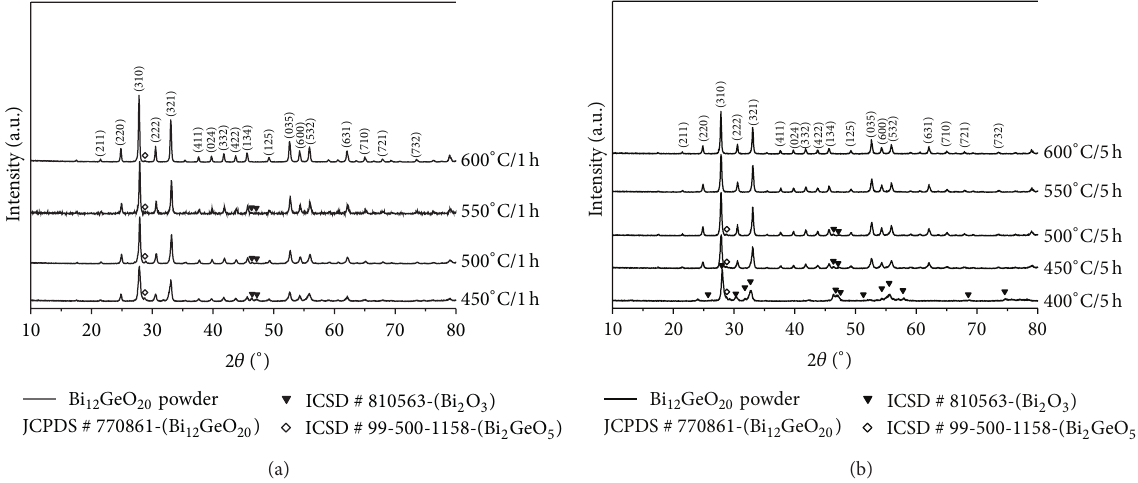
Figure 2: X-ray diffraction patterns of the Bi 12 GeO 20 powders calcined at temperatures from 400 to 600 ∘ C with calcination times of 1 h or 5